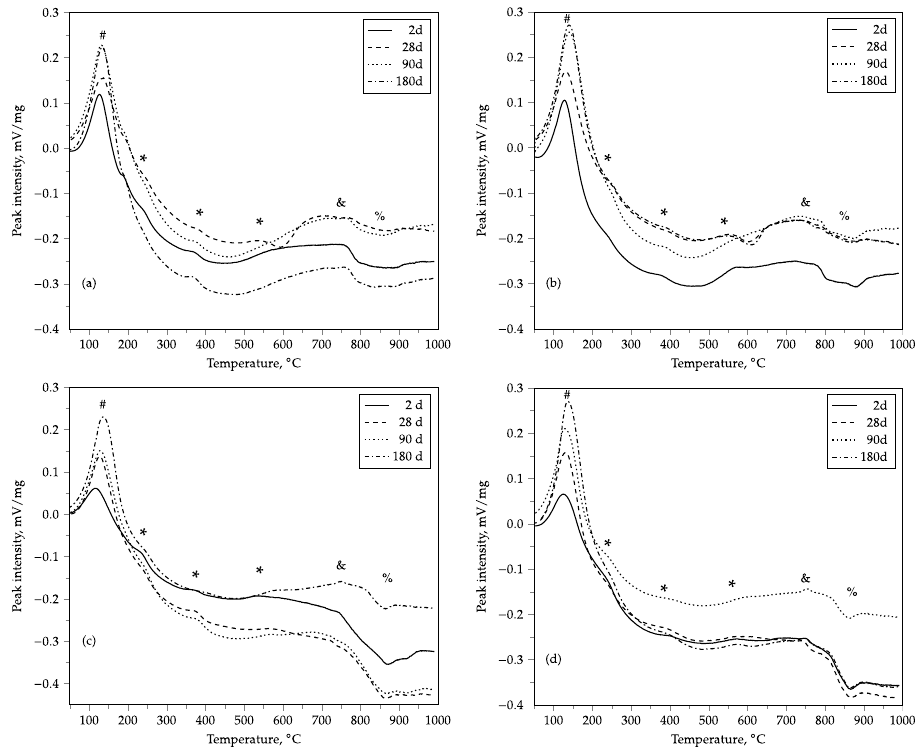
Figure 3. DT for AI ( a ), AC ( b ), BI ( c ) and BC ( d ) hydrated pastes (w/s = 0.50) for 2, 28, 90 and 180 days. Symbols: # = calcium silicate hydrates/calcium silico (aluminate) hydrates (C-S-H/C-(A)-S-H); * = hydrotalcite; & = calcite (CaCO 3 ); % = crystallization slag effect. Five endothermic peaks were observed for all the investigated curing periods [59].